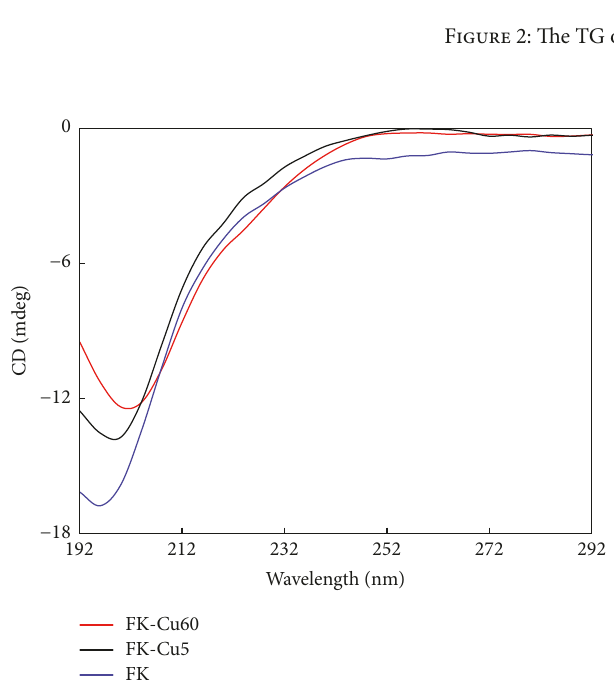
Figure 3: The CD spectra of FK-GlyCu 𝑥 complexes.